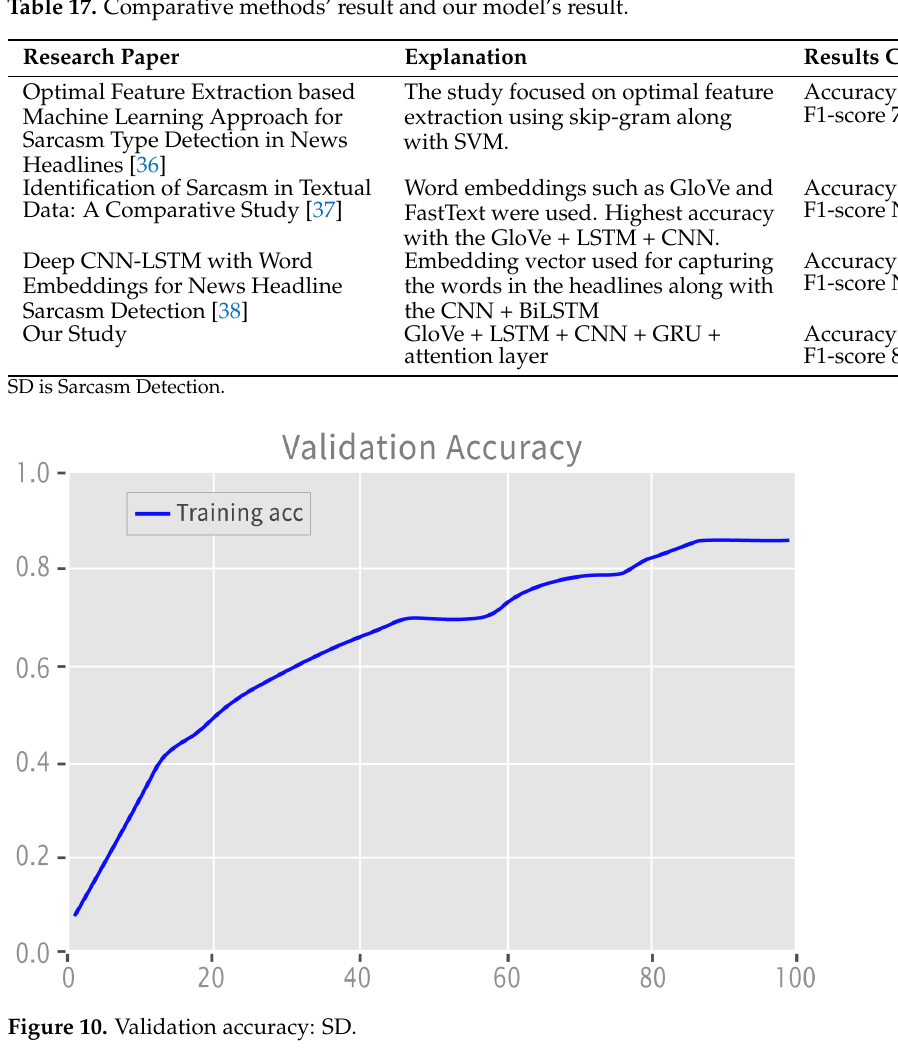
Table 17. Comparative methods’ result and our model’s result.